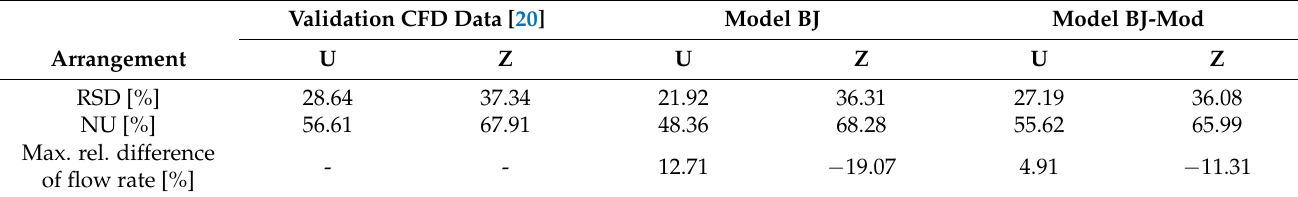
Table 7. Flow non-uniformity predicted using the analytical models and CFD simulations.